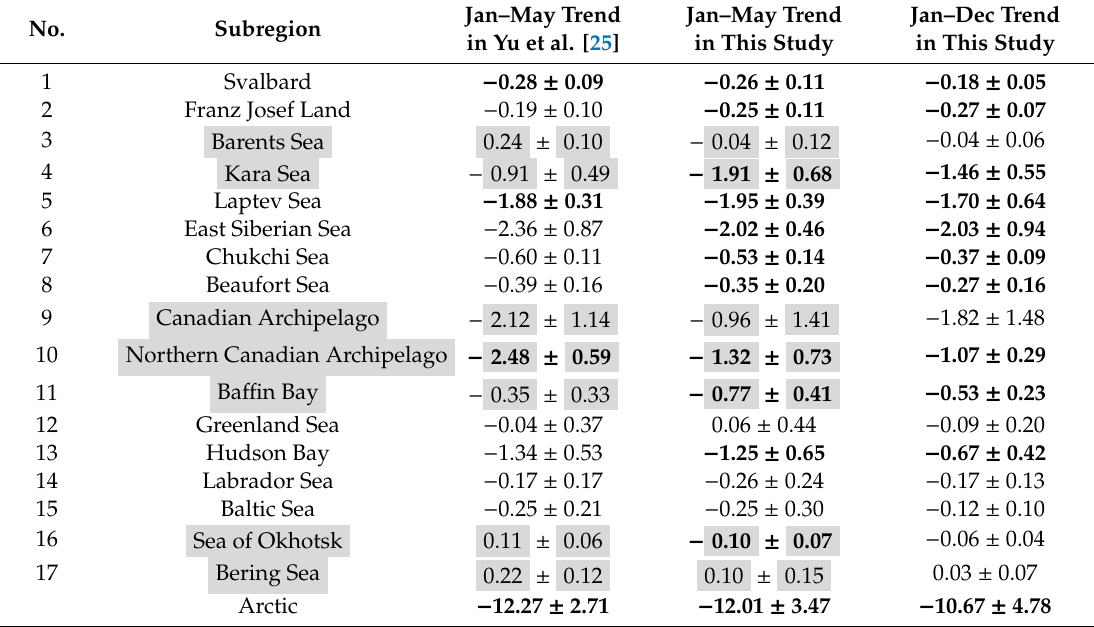
Figure 5. Long-term trend of landfast ice extent in the 17 subregions ( a – e ), Northeast Passage and Northwest Passage ( f ) during 1976–2018. Table 2. Annual trend (10 3 km 2 / yr) of the landfast ice extent in the 17 subregions. The F-test is used to estimate the significance of the trend independent of the statistical data, and bold numbers indicate that the trends are significant at the 0.01 level. Note that the trend reported by Yu et al. [25] was based on the time series from 1976 to 2007, while the trend in our study was based on the time series from 1976 to 2018. The subregions highlighted in gray represent trends with obvious